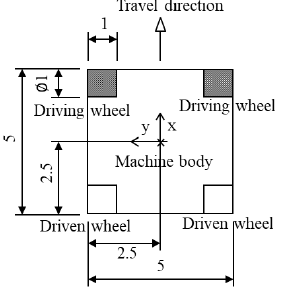
Figure 1. A four-wheeled model. Four wheels are located at the corners of the machine body. Front gray wheels show driving wheels and rear white wheels show driven wheels. The machine is assumed to be a cube of 5 mm on a side, and the wheel is a cylinder of 1 mm in diameter and 1 mm in length. The skid-steered method causes the microrobot to turn using a speed difference between the left and right driving wheels (front wheels), which are fixed and cannot turn sideways; the method is used for steering in the horizontal plane.